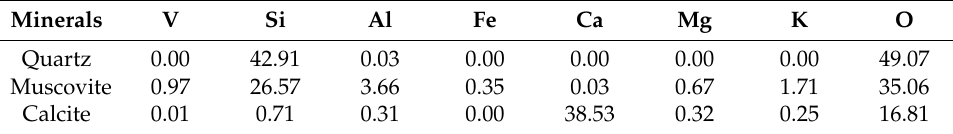
Table 2. EPMA result of the raw ore wt